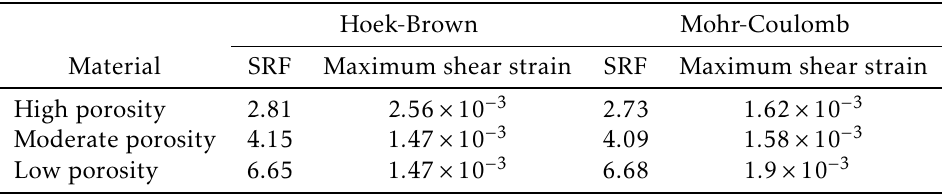
Table 4: Summary of key stability indicators for finite element model of volcano stability for low, moderate, and high porosity volcanic rocks with a GSI of 55 and density of 2650 kg m − 3 , calculated using the m i values from Table 2, using Hoek-Brown failure criterion and Mohr-Coulomb failure criterion derived for a slope height of 250 m. SRF = Strength reduction